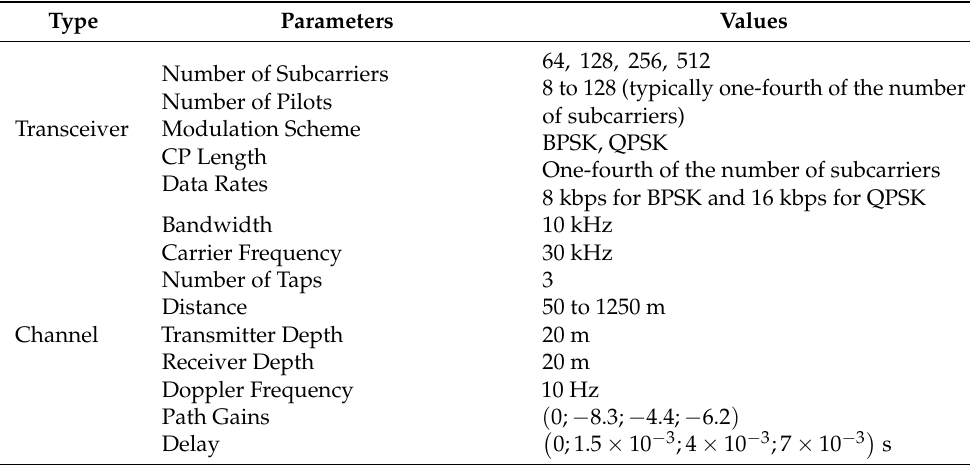
Table 1. Simulation